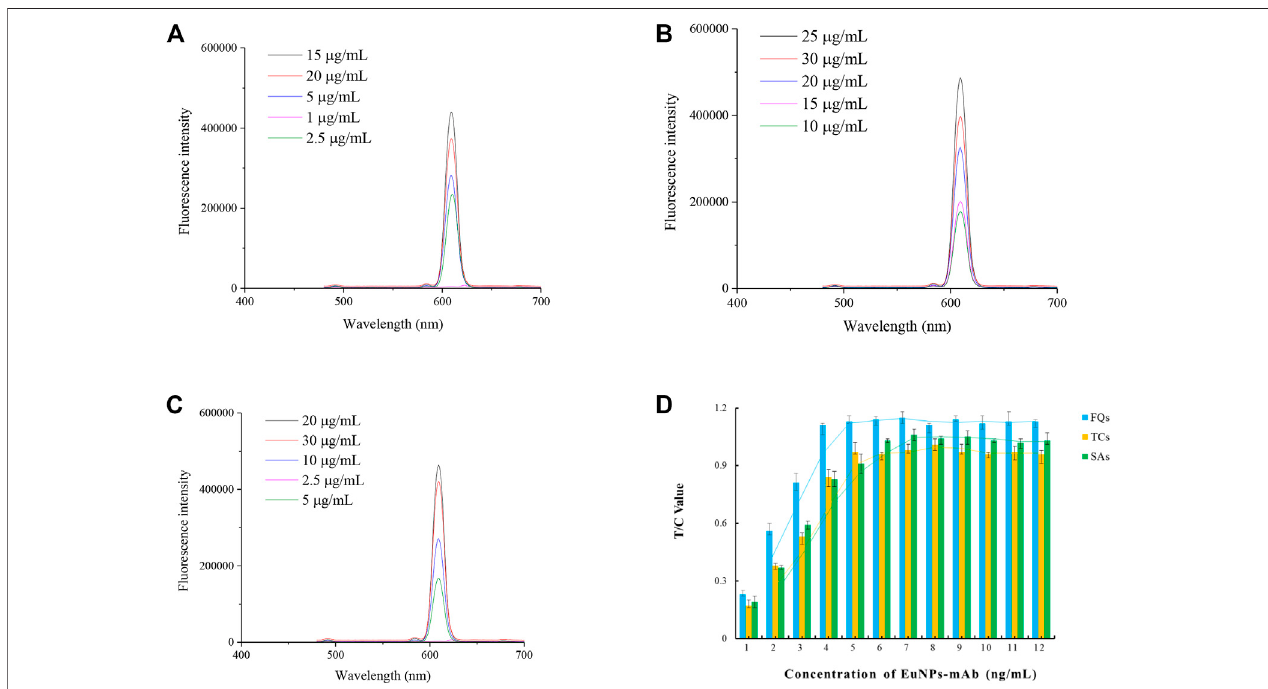
FIGURE 2 | Optimisation of EuNPs-antibody conjugates. (A) Effect of the amount of FQs-mAb labelling on the detection capability of the probe. (B) Effect of the amountofSAs-mAblabellingonthedetection capabilityoftheprobe. (C) EffectoftheamountofTCs-mAblabellingonthedetection capabilityoftheprobe. (D) Effectof probe incorporation on the detection capacity of